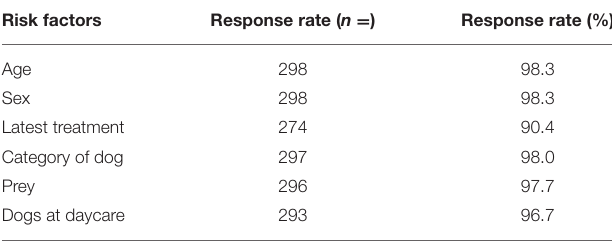
TABLE 1 | Response rates from the